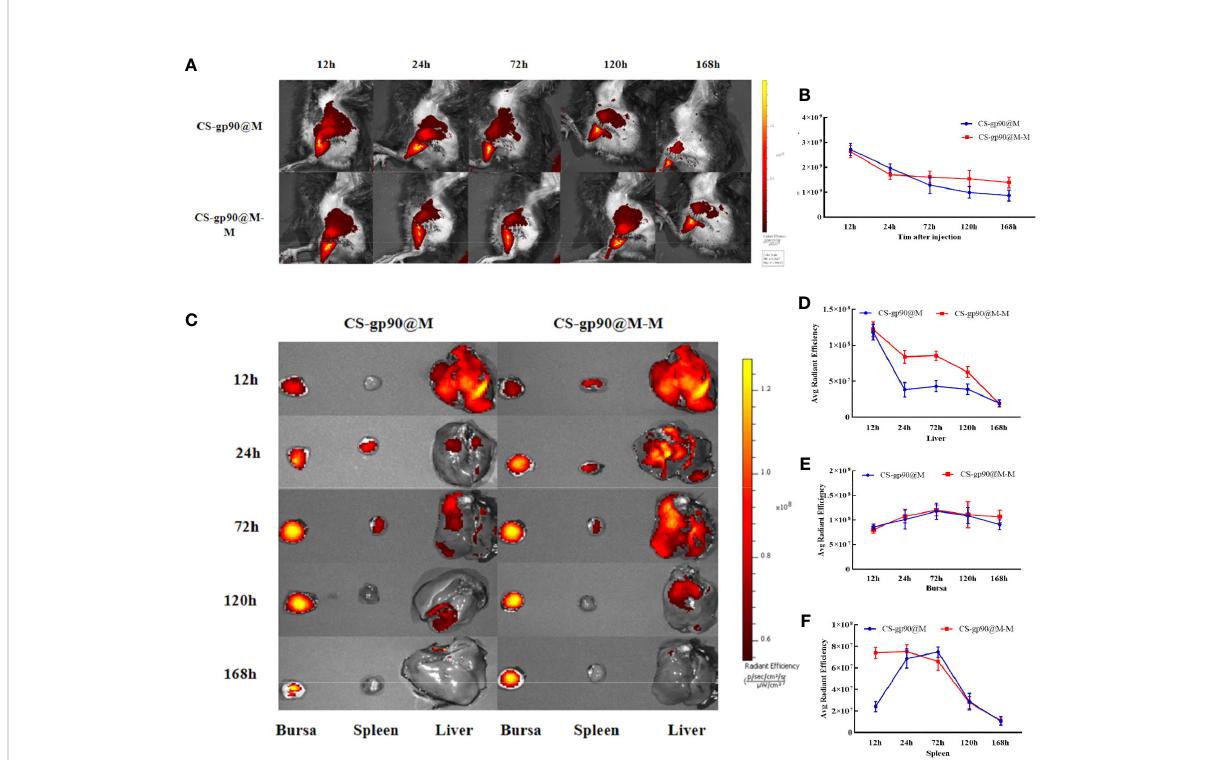
FIGURE 6 Release and biodistribution of CS-gp90@M-M NPs in vivo . (A, B) In vivo fl uorescence images of chicks and the attenuation of the fl uorescent dyes over time (C – F) Direct imaging of excised organs. Live animal imaging of chicks. The vaccine formulation was stained using a Cy5.5 fl uorescent dye and chicks were immunized with CS-gp90@M-M and CS-gp90@M NPs. Live-animal imaging and fl uorescence intensity in chicks at 24, 48, 72, and 168 h after injection was determined using an in vivo optical imaging system (A, B) . Direct imaging and fl uorescence intensity of the bursa, spleens, and livers of the injected chicks was determined at 12, 24, 72, 120, and 168 h after injection (C – F)